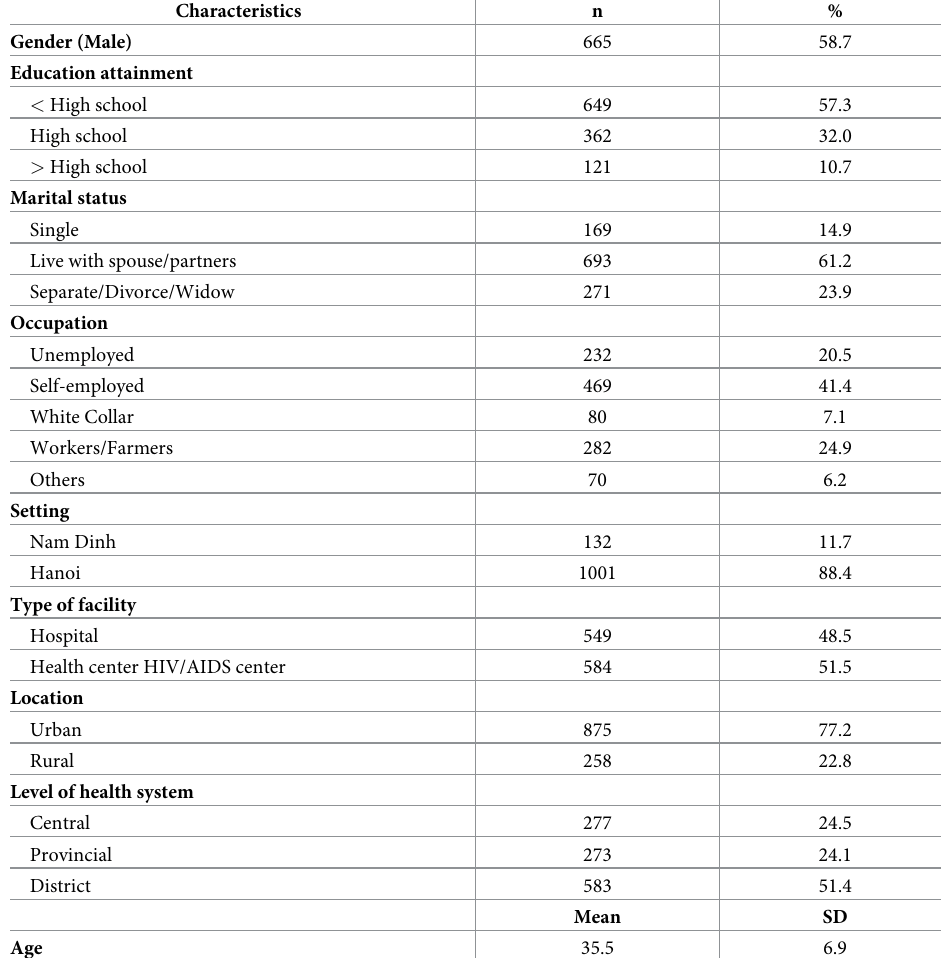
Table 1. Demographic characteristics of respondents and facilities (n =